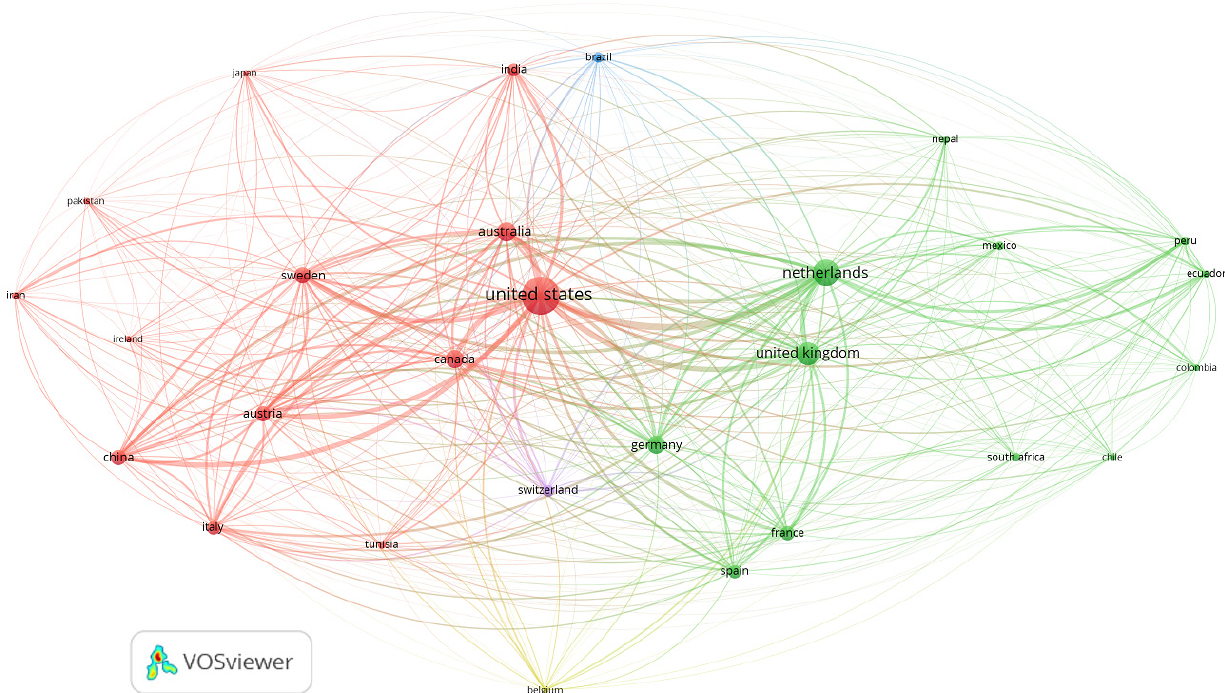
Figure 6. Bibliographic coupling of countries.